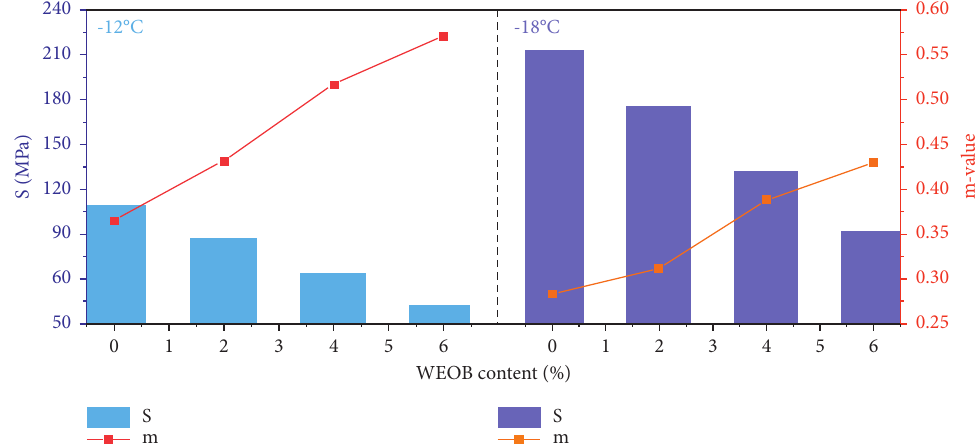
Figure 10: BBR test results of WEOB/SBS-modified binders at − 12 ° C and − 18 ° C.